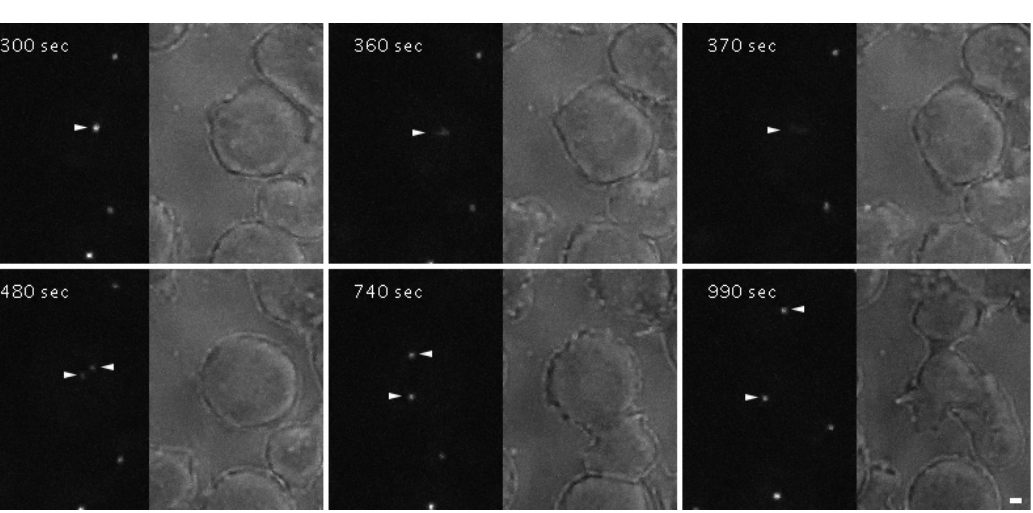
Figure 2. CDK5RAP2 is present at mitotic spindle poles. ( A ) Immunofluorescence microscopy of AX2 control cells in interphase and mitosis (as indicated) stained with rabbit anti-CDK5RAP2 and rat anti- α -tubulin. DNA staining with DAPI is shown in the merged image. Secondary antibodies were anti-rabbit AlexaFluor 488 and anti-rat AlexaFluor 568. Cells were fixed with glutaraldehyde. Maximum intensity projections of deconvolved images. To allow comparison of labeling intensities in mitotic vs. interphase cells, the maximum display intensity of the green channel was set using neighboring interphase cells. Bar = 2 µm. ( B ) Immunoblot of a nuclear extract of untransformed AX2 cells stained with anti-CDK5RAP2/anti-rabbit-alkaline phosphatase. Color detection was performed with nitroblue tetrazolium chloride (NBT) and bromo-chloro-indolyl-phosphate (BCIP).